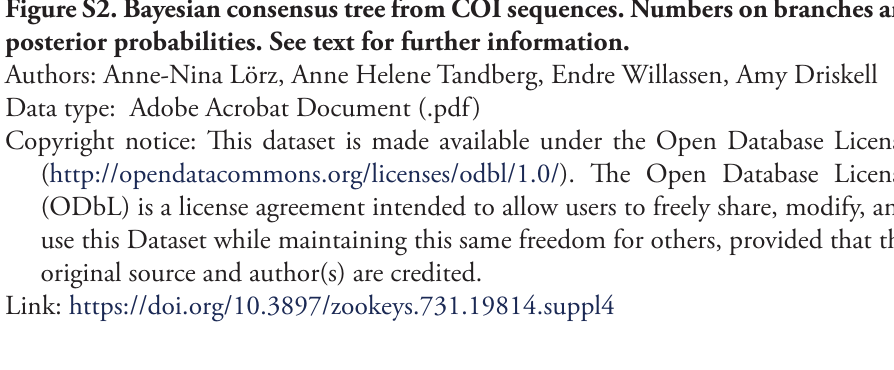
Figure S2. Bayesian consensus tree from COI sequences. Numbers on branches are posterior probabilities. See text for further